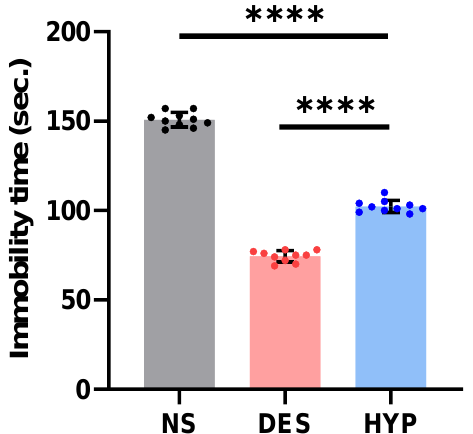
Figure 7. Effect of the administration of hypericin (F1) on immobility time in the tail suspension test. Statistically significant assessed by an ordinary one-way ANOVA. Graph bars represent means ± SEM. **** p < 0.0001. ( n = 10 for each group). NS: normal saline, DES: desipramine, HYP: hypericin.